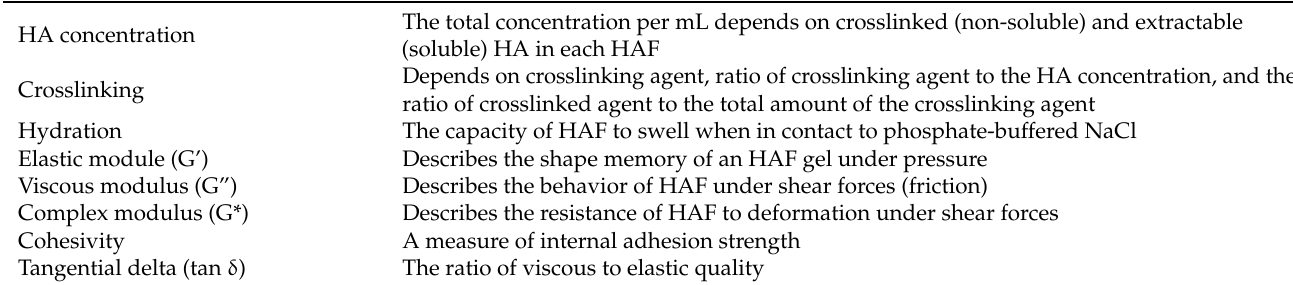
Table 1. Basic biophysical and rheological qualities of HAF [3].